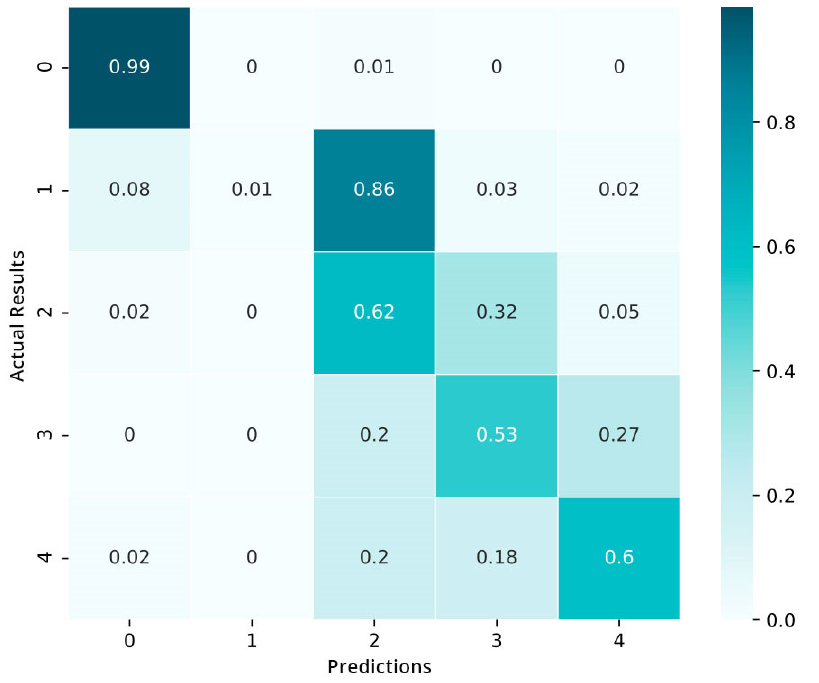
Figure 11. Confusion matrix pre-fine-tuning.